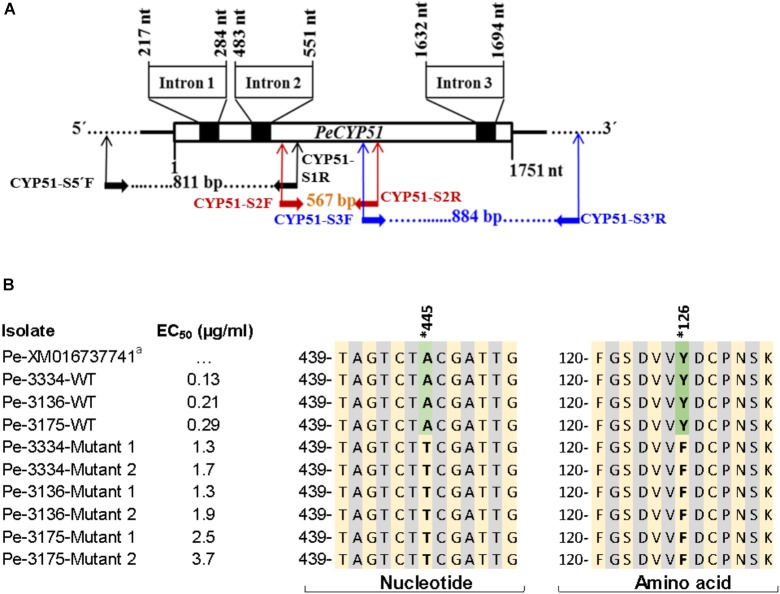
Sequencing and nucleotide and amino acid sequence alignment of PeCYP51.
(A) Schematic representation of the CYP51 gene of Penicillium expansum including the positions of the introns and primer binding sites used for CYP51 sequencing. (B) Nucleotide and amino acid sequences alignment of P. expansum isolates, with different EC50 values, i.e., 3 wild-type and 2 resulting mutants from each WT with the reference GenBank sequence accession # XM016737741. Asterisk indicates the nucleotide and codon (or equivalent) where a mutation has been seen and reported previously to confer resistance to DMI fungicides.